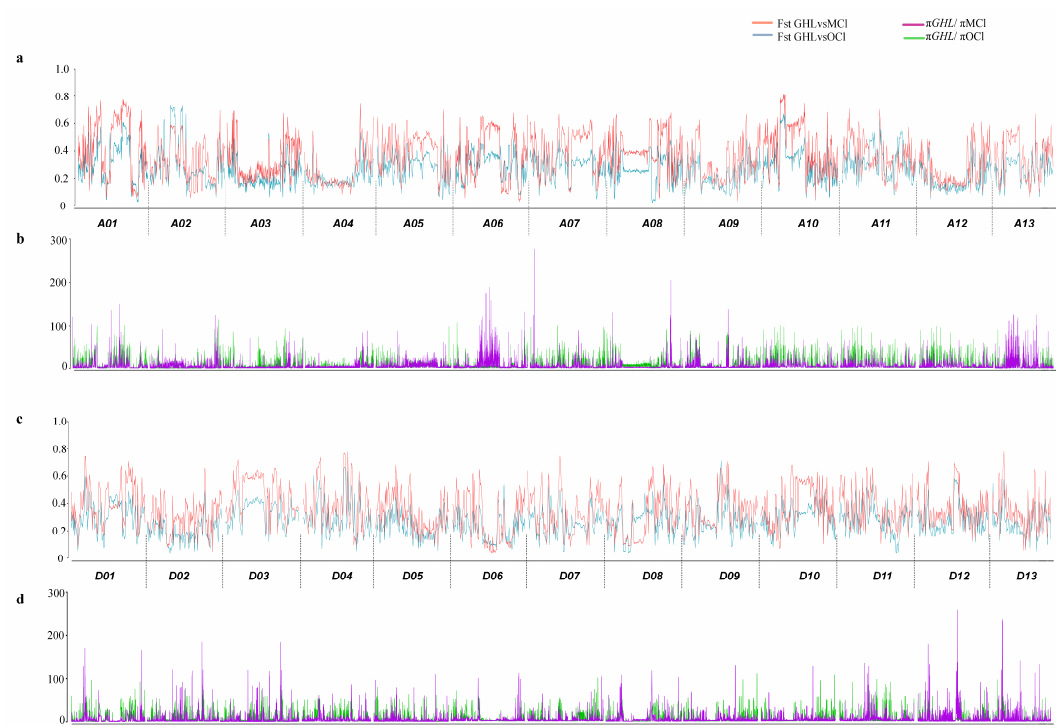
Figure 4. Genetic differentiation and selection signals among G. hirsutum landraces (GHL), modern cultivars (MCl) and Obsolete cultivars (OCl) ( a ) Population divergence ( F st) for At sub-genome (Chr A01–A13), ( b ) π GHl /π MCl (Purple columns) and π GHl /π OCl (Green columns) values (genetic diversity in G. hirsutum landraces (GHL) as compared to MCl and OCl for At sub-genome (Chr A01–A13), ( c ) Population divergence ( F st) for Dt sub-genome (Chr D01–D13), ( d ) π GHl / π MCl (Purple columns) and π GHl / π OCl (Green columns) values (genetic diversity in G. hirsutum landraces (GHL) as compare to MCl and OCl for Dt sub-genome (Chr